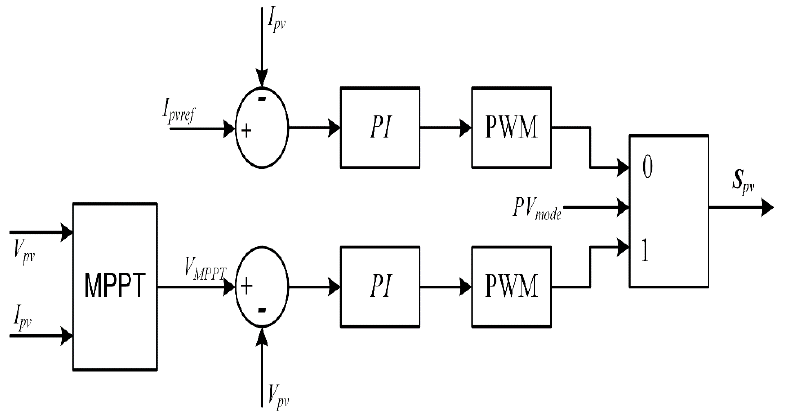
Figure 6. Control scheme for PV boost converter.